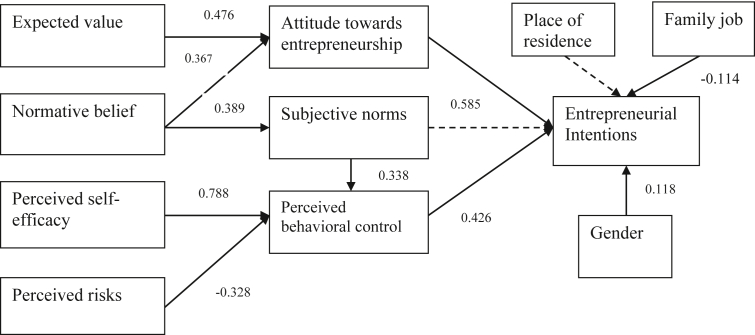
The relationship between the constructs in the model of engineering stutdents sample. Notes: Dotted lines are not statistically significant.